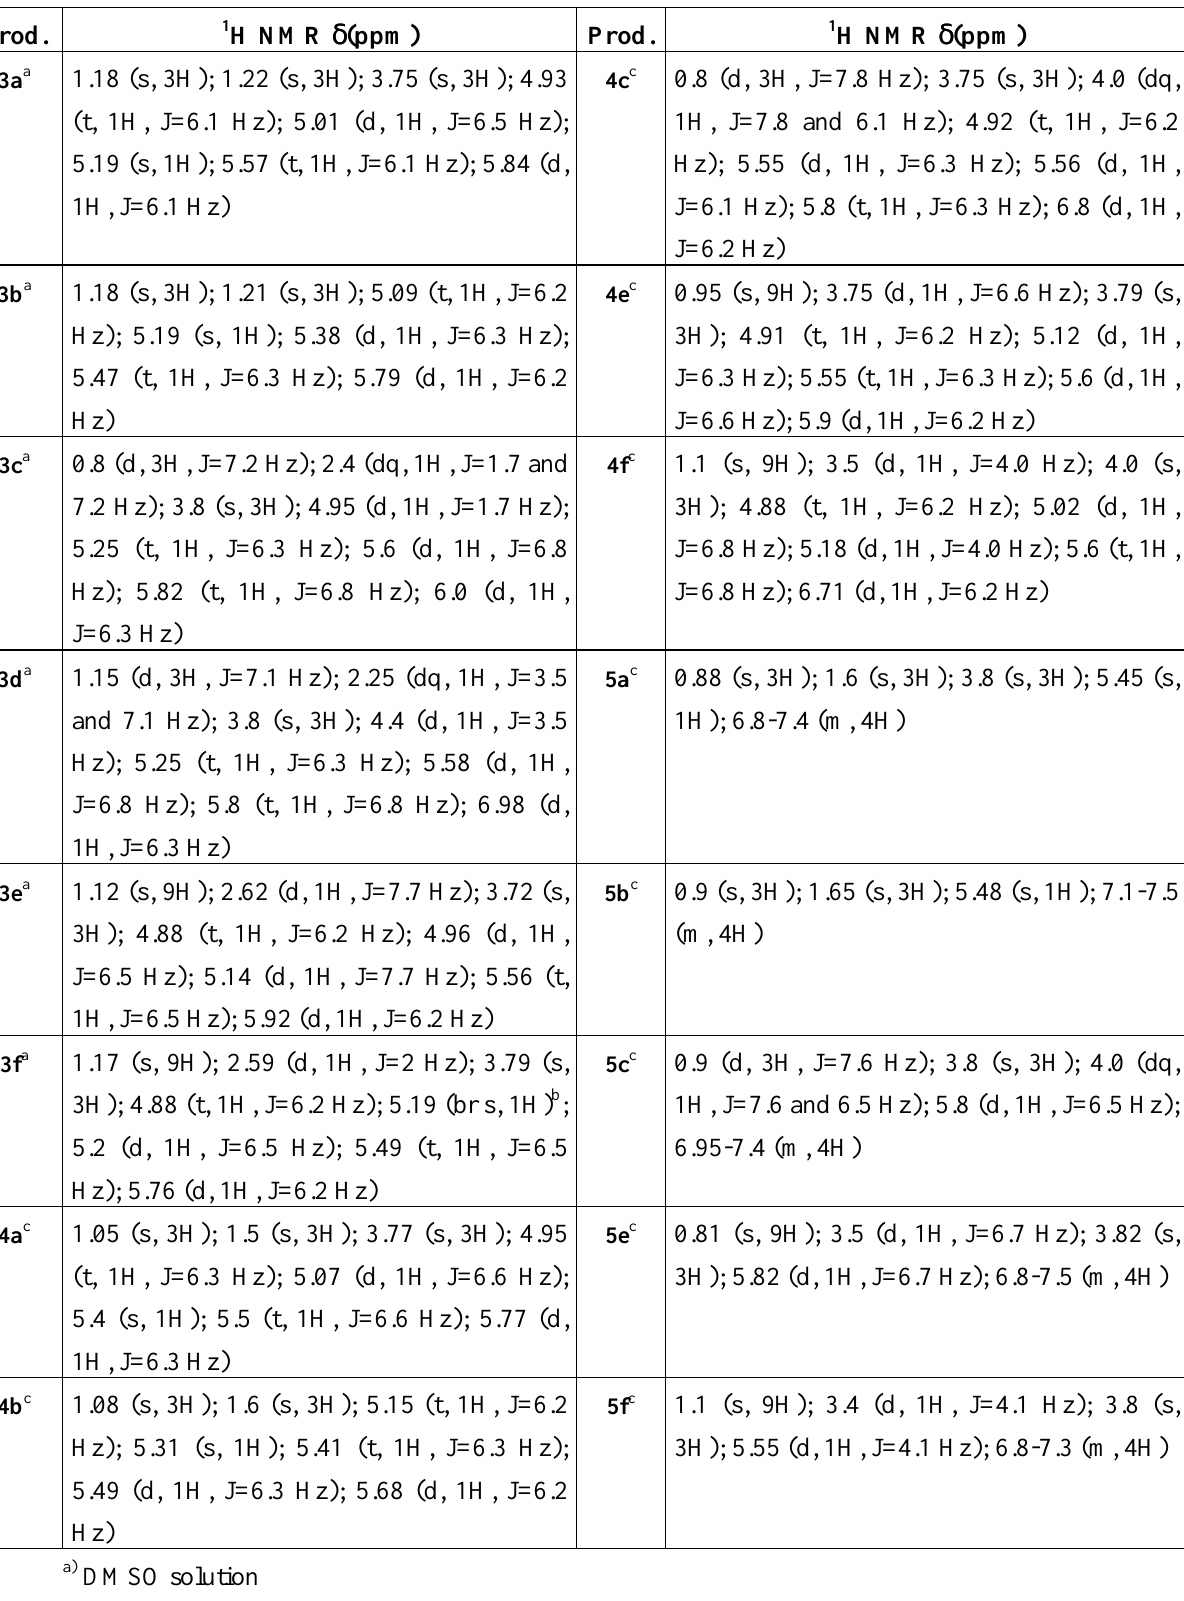
Table 2. Spectroscopic